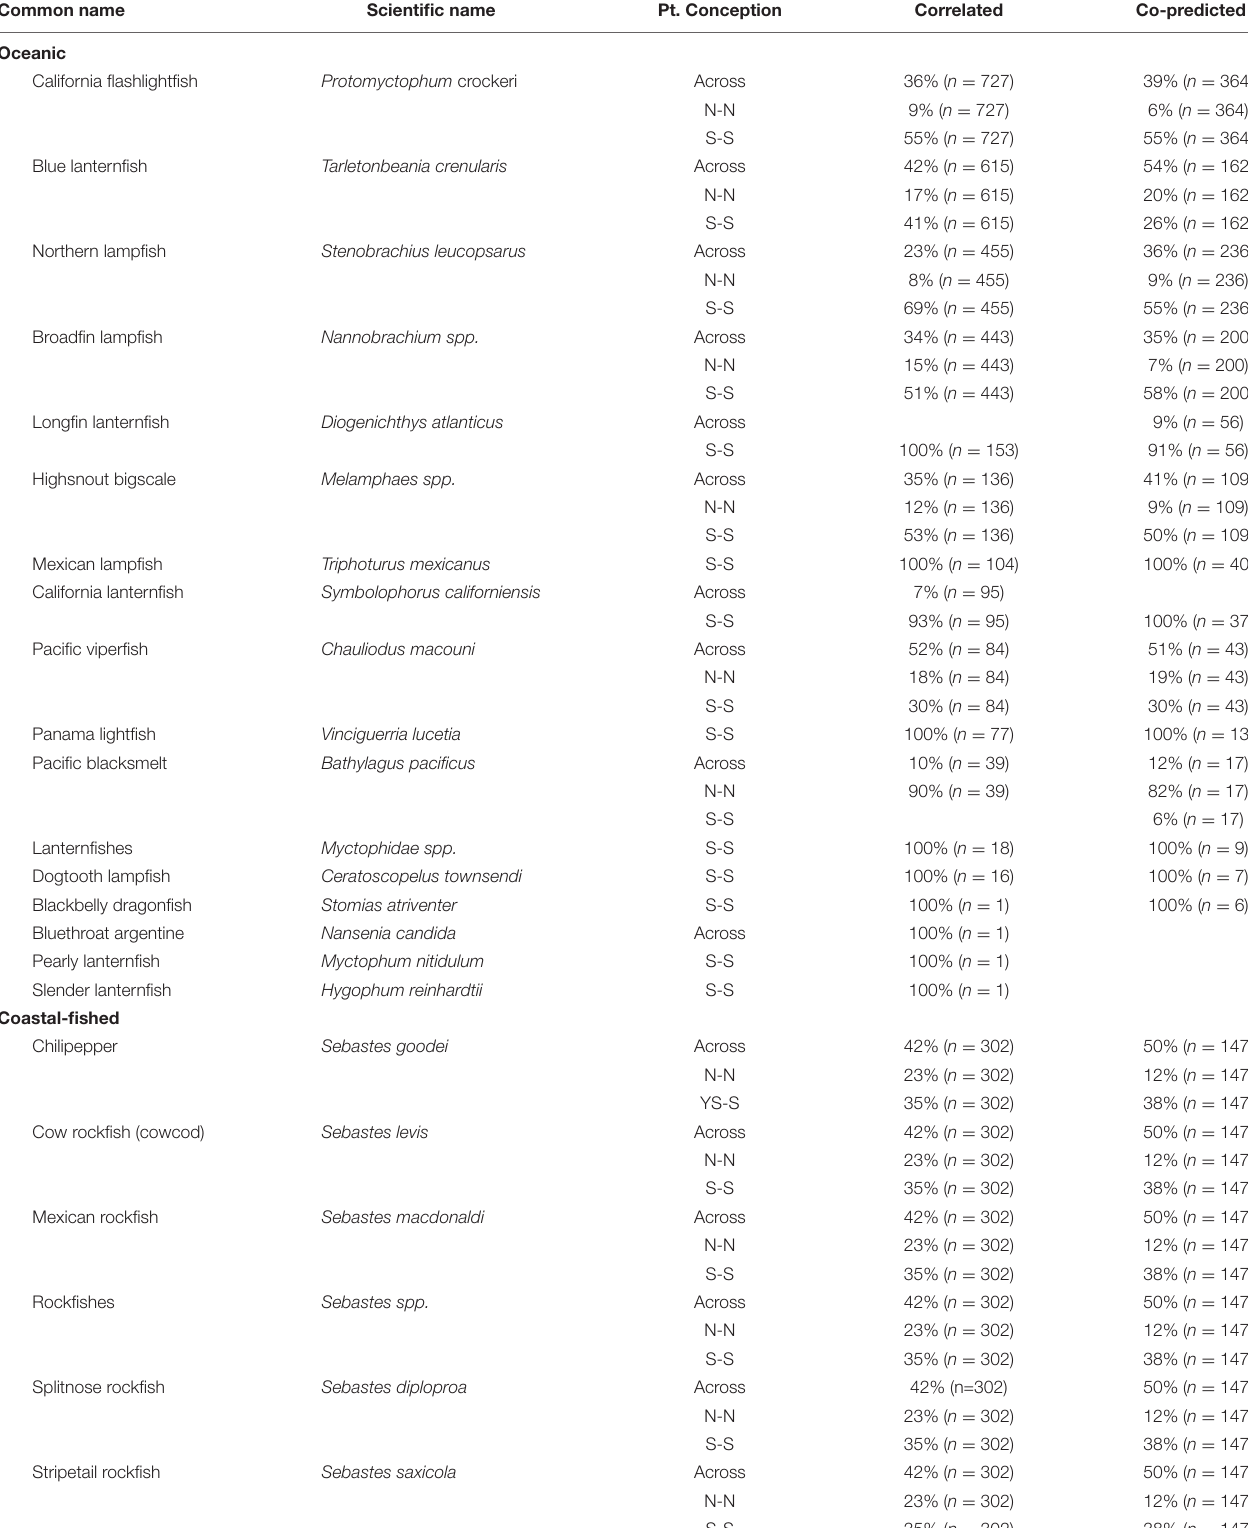
TABLE 2 | Percentages of correlated and co-predicted (number of unique station pairs in parantheses) for individual species grouped by